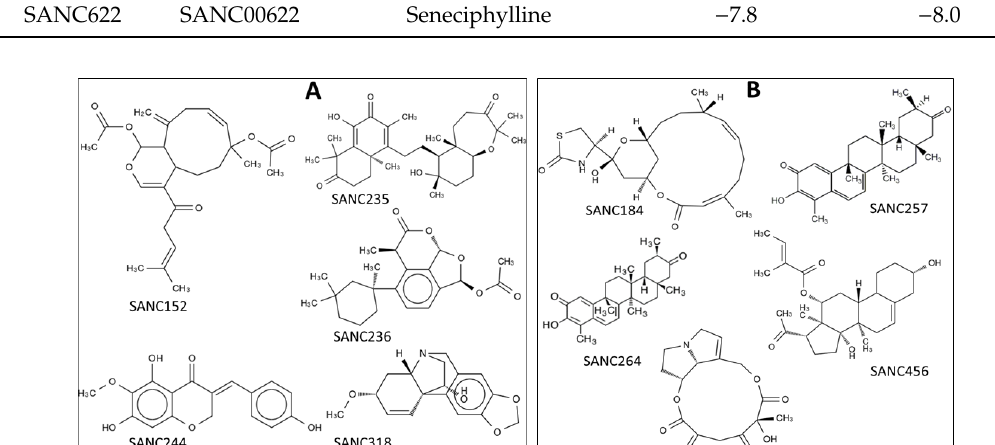
Figure 1. 2D representations of identified South African natural compound hits against PfProRS active and allosteric sites. ( A ) Identified orthosteric hit compounds against PfProRS. ( B ) Identified allosteric hit compounds against PfProRS allosteric site.